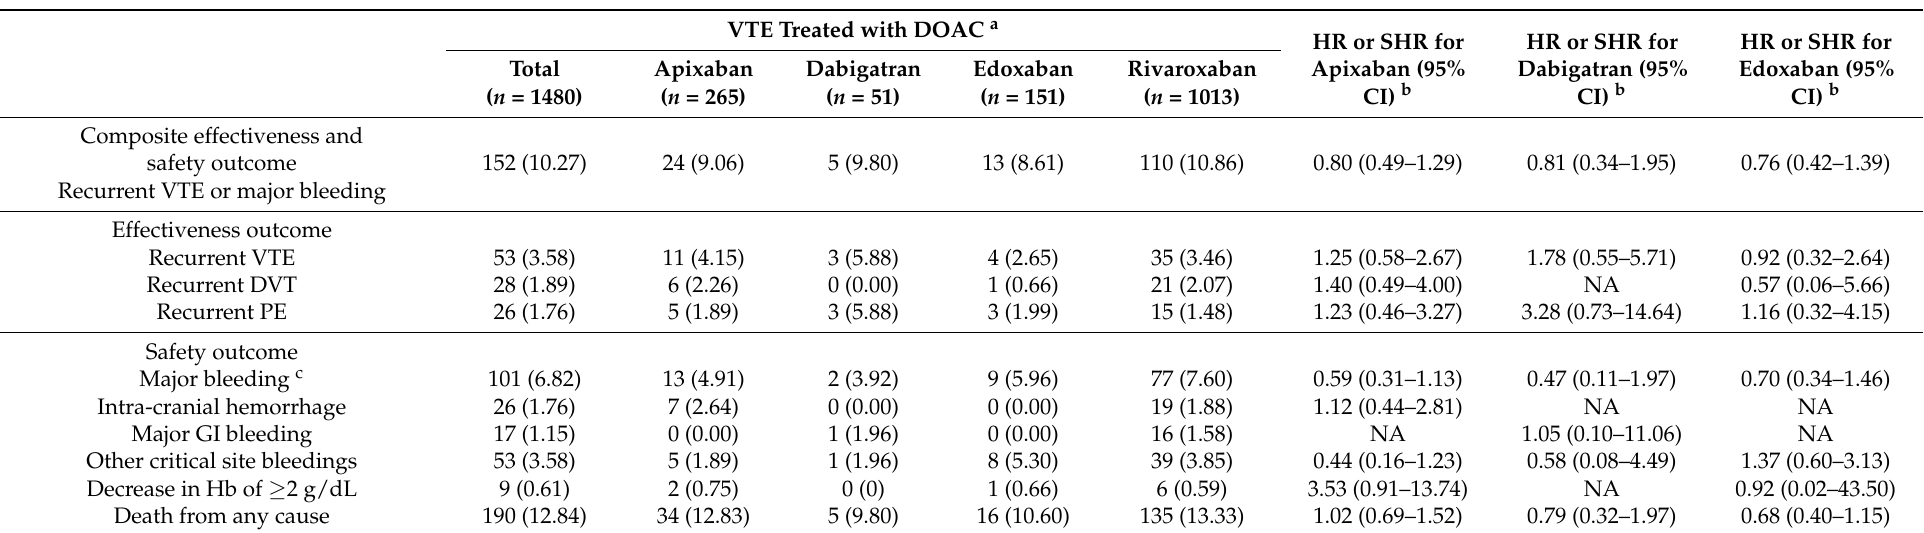
Table 2. Effectiveness and safety clinical